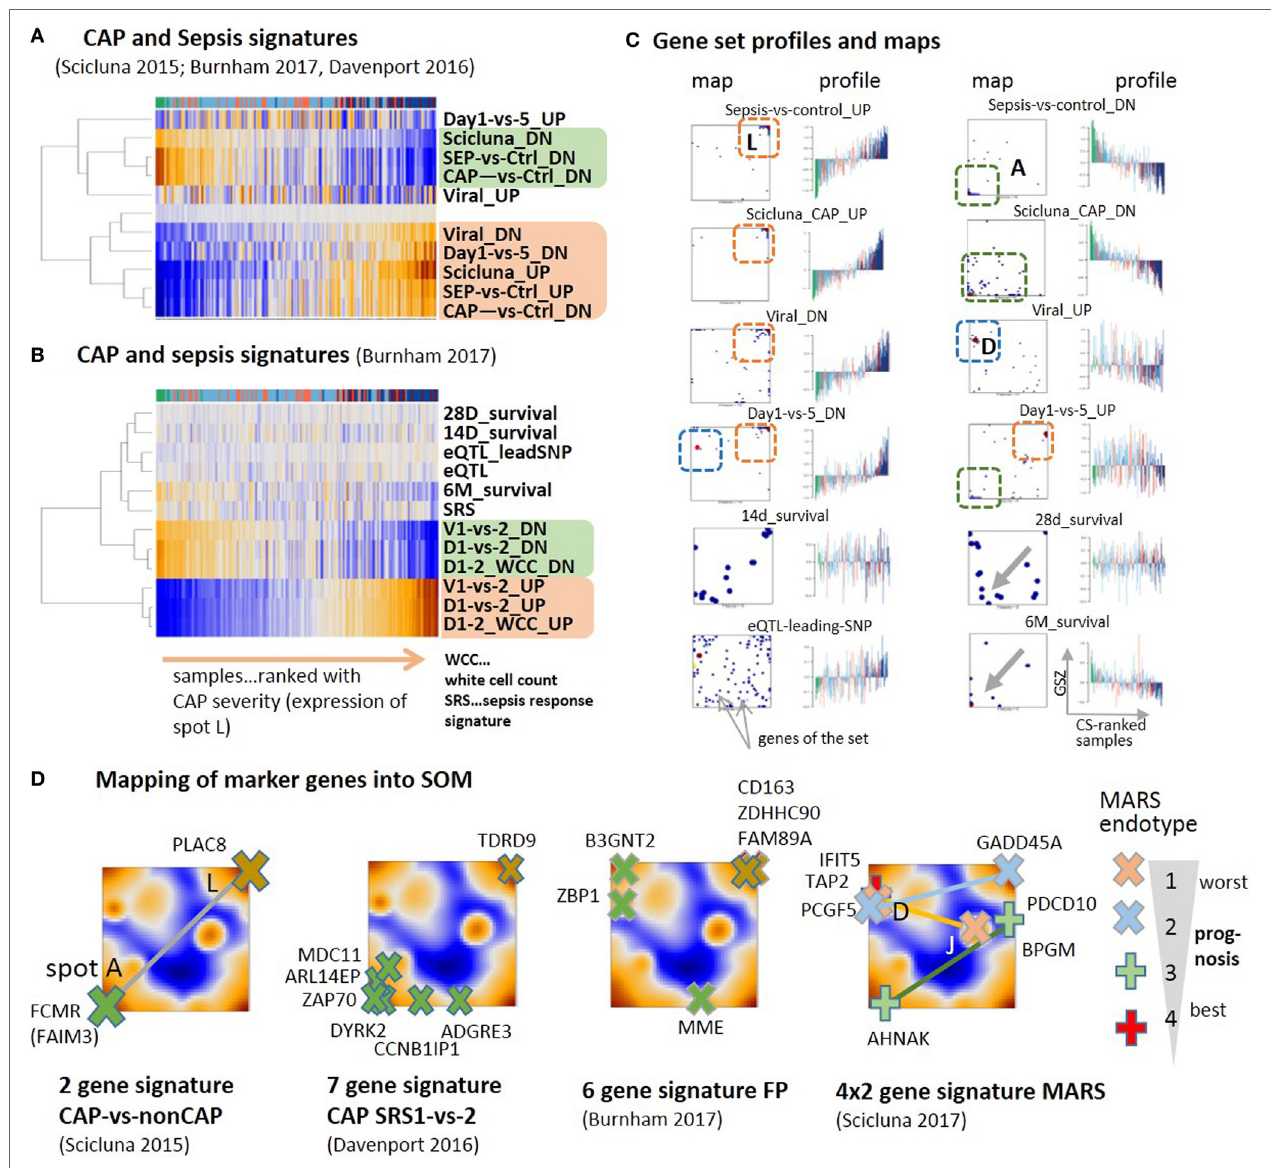
FigUre 6 | Previous community-acquired pneumonia (CAP) and sepsis signatures were taken from Ref. (9–11, 79) and mapped onto the data analyzed here. (a,B) Expression heatmaps (GSZ-score) of the gene signatures mostly show two types of signatures, which antagonistically switch between normal conditions and CAP. (c) Profiles and gene set maps (genes are indicated by dots in the maps) reveal further details about the disease course and the noisiness of gene expression. Regions of increased local densities of signature genes were indicated by red and green frames. (D) Maps of selected sets of marker genes accumulate in regions of the spots detected here. MARS genes were provided pair-wisely for up- and downregulation in each of the MARS endo-types (11). The pairs are connected by lines as a guide for the